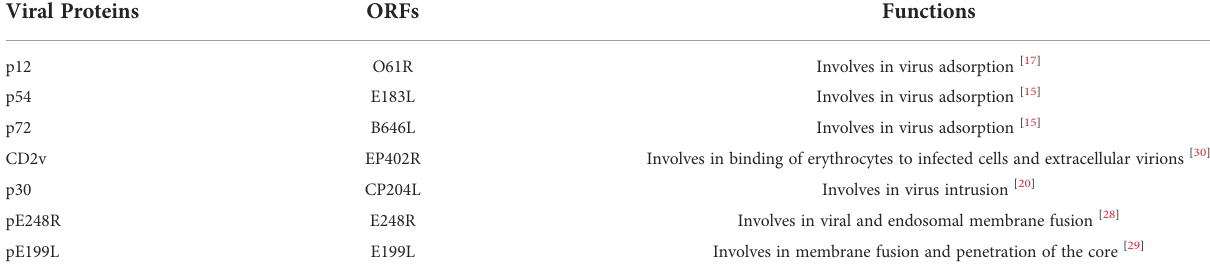
TABLE 1 ASFV encodes proteins involved in adsorption and invasion processes. Viral